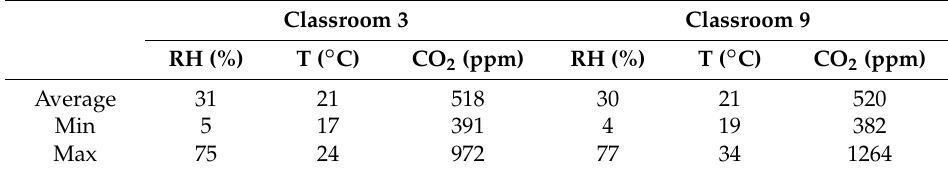
Figure 7. CO 2 concentration, relative humidity, and temperature duration in Classrooms 3 and 9 during school’s occupancy hours, from 8 a.m. to 5 p.m. on Monday–Friday, measured continuously from 24 August 2016 to 9 May 2017 after ventilation intervention was conducted. Table 4. Relative humidity, temperature, and CO 2 in Classrooms 3 and 9 during school’s occupancy hours, from 8 a.m. to 5 p.m. on Monday–Friday, between 24 August 2016 and 9 May 2017.